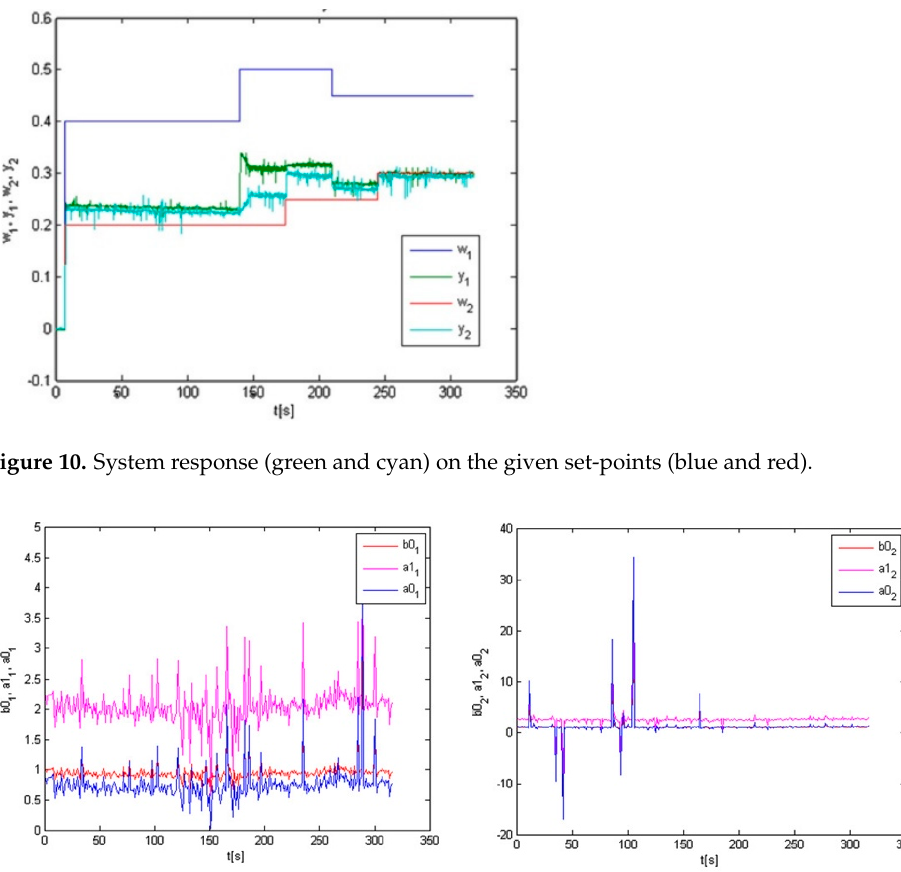
Figure 11. System pre-identification using recursive instrumental variable—1st subsystem ( left ), 2nd ( right ) .